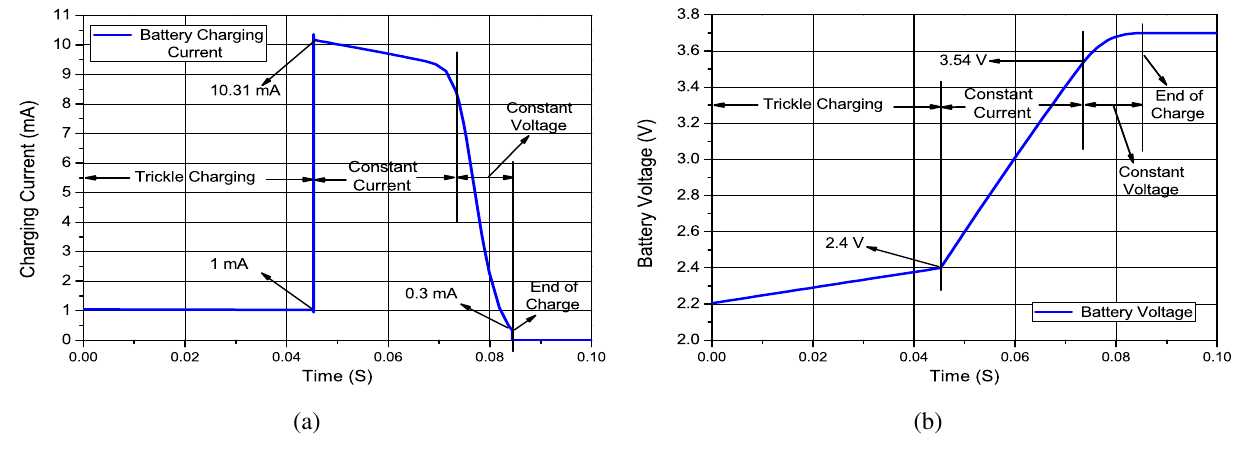
Simulated: ( a ) charging current; ( b ) instantaneous battery voltage with charging